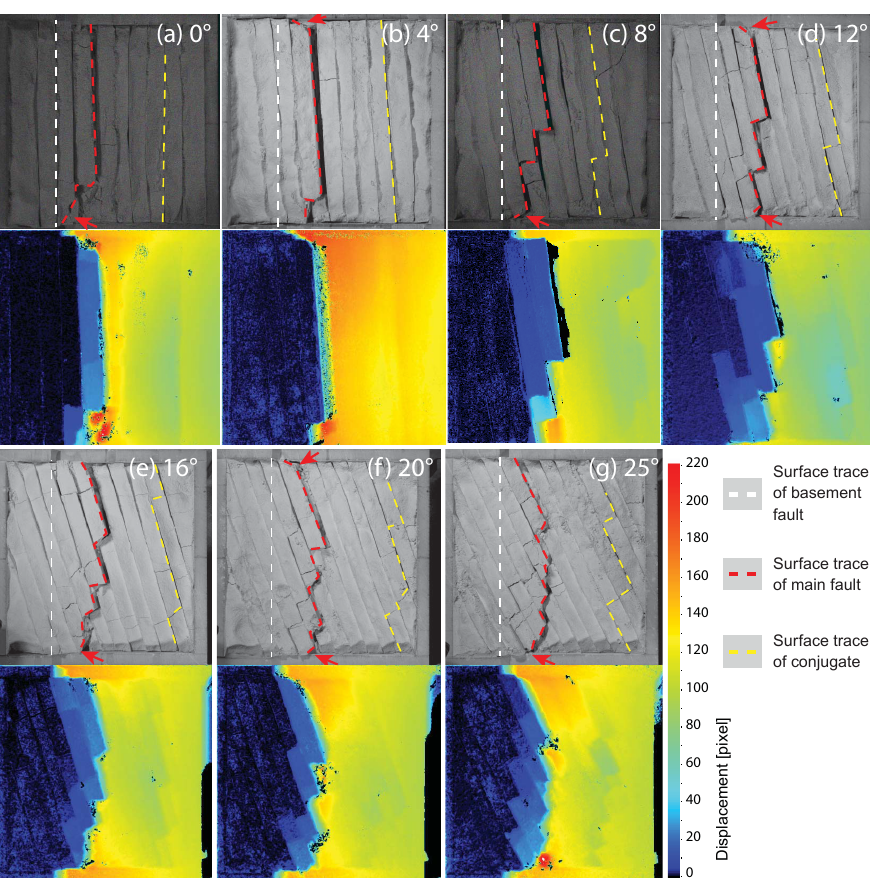
Figure 5. Map-view photographs of the experiment series at maximum displacement. Red lines mark the master fault; yellow lines mark the main antithetic fault. White lines illustrate the extent of the basement fault at the surface. For each experiment we show a respective PIV image illustrating the total deformation in map view. Color code gives the displacement in pixels. Note that different blocks experienced different amounts of displacement, while localization is always at pre-existing joints.